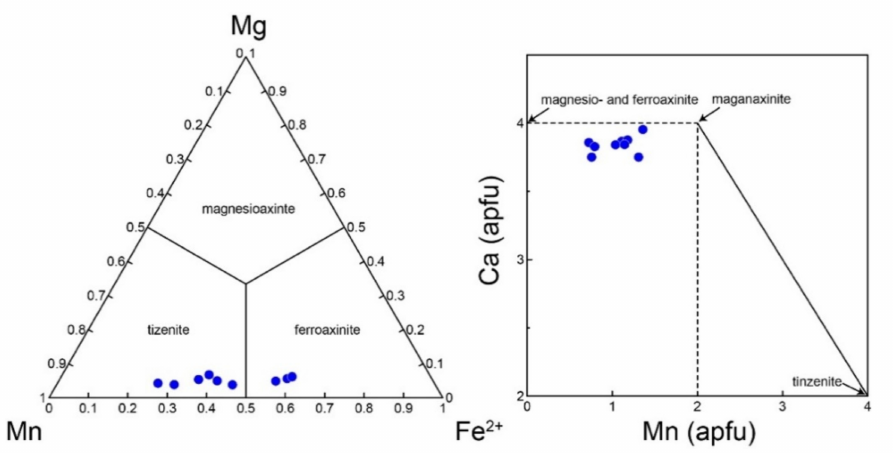
Figure 10. Chemical compositions of analyzed axinite after [20].